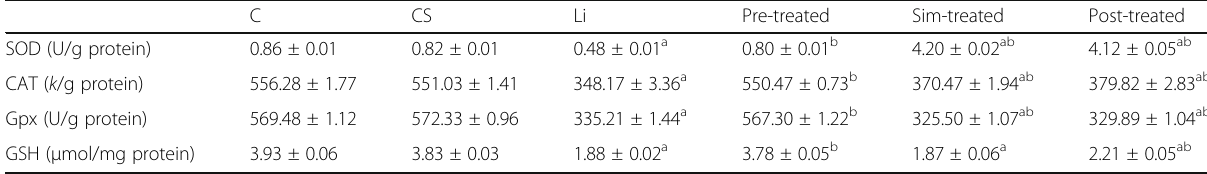
Table 2 Prophylactic and therapeutic effect of chitosan on activities of the antioxidants against Li 2 CO 3 -induced renal toxicity in rats